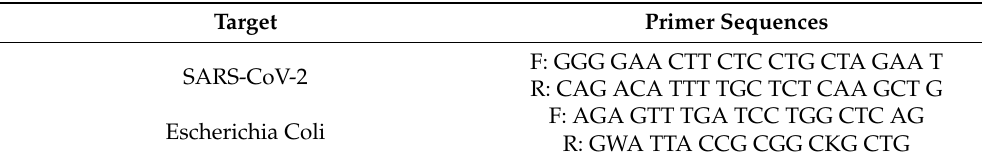
Table 1. The primer